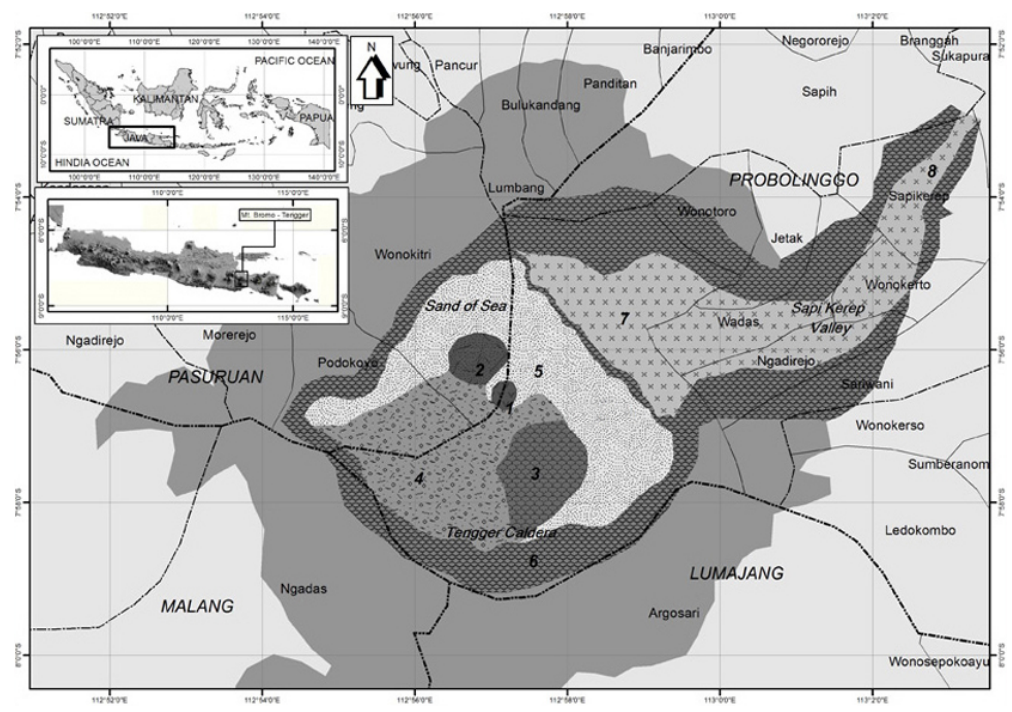
Figure 2. Bromo Volcano and its landforms: (1) Gunung Bromo and its crater; (2) a Strombolian cone, Gunung Batok; (3) complex of rest volcanic cone (G. Kursi); (4) complex of rest volcanic cone (G. Widodaren) and Segara Wedi; (5) Sand of Sea ; (6) Tengger caldera formation (upper and middle slope); (7) foot slope of Tengger caldera (Sukapura Barranco); (8) Sapi Kerep outlet valley (interpretation from SRTM Image and field survey.)